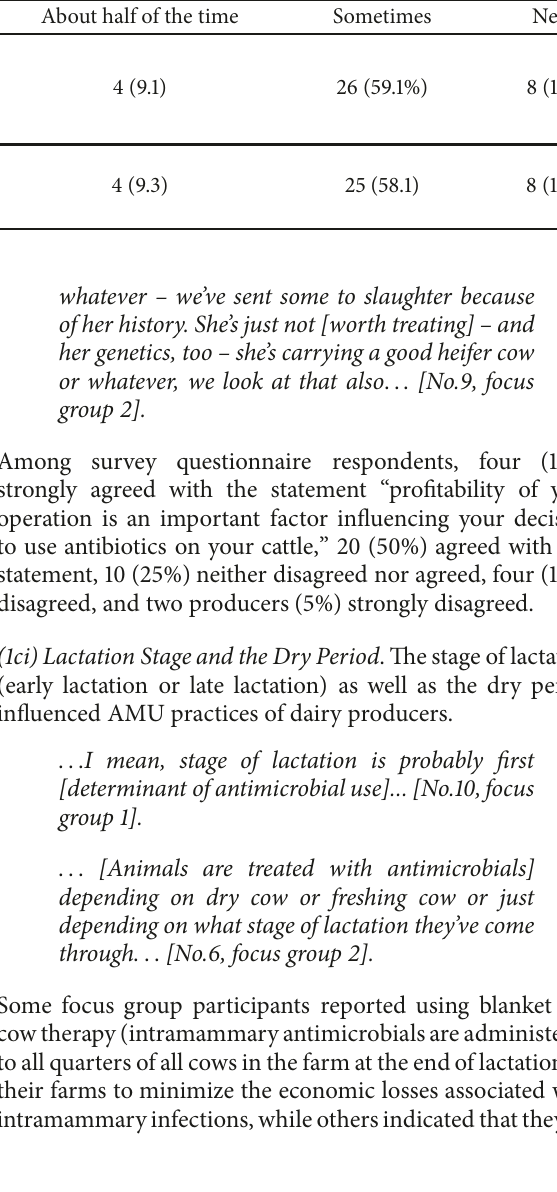
Number of participants (percentage) Always Most of the time About half of the time Sometimes Never 0 (0)